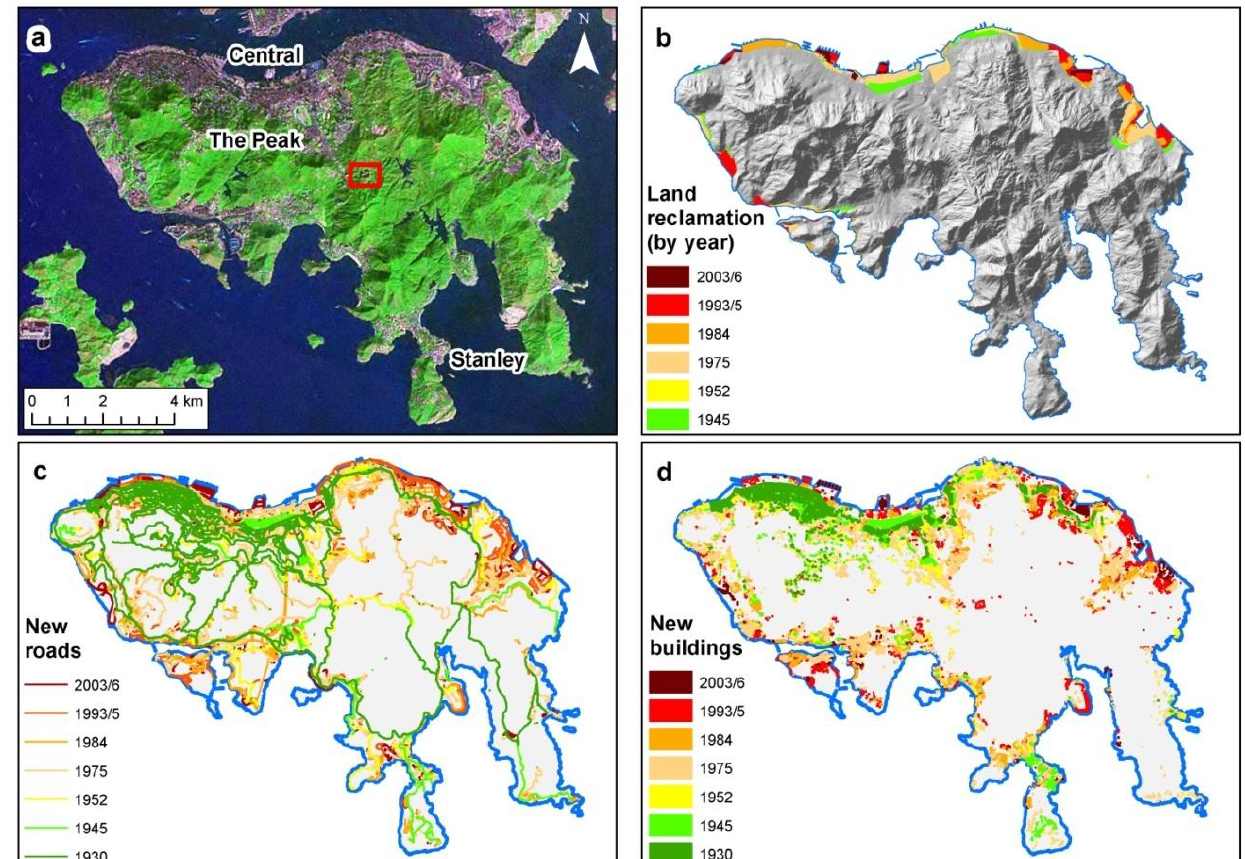
Figure 3. The reconstructed development stages of the Island of Hong Kong (between 1930 to the mid-2000s): Landsat false color image ( a ); land reclamation from the sea ( b ); development of the road network ( c ); and the development of built-up areas ( d ). The red rectangle in Figure 2a shows the location of Parkview residential project.